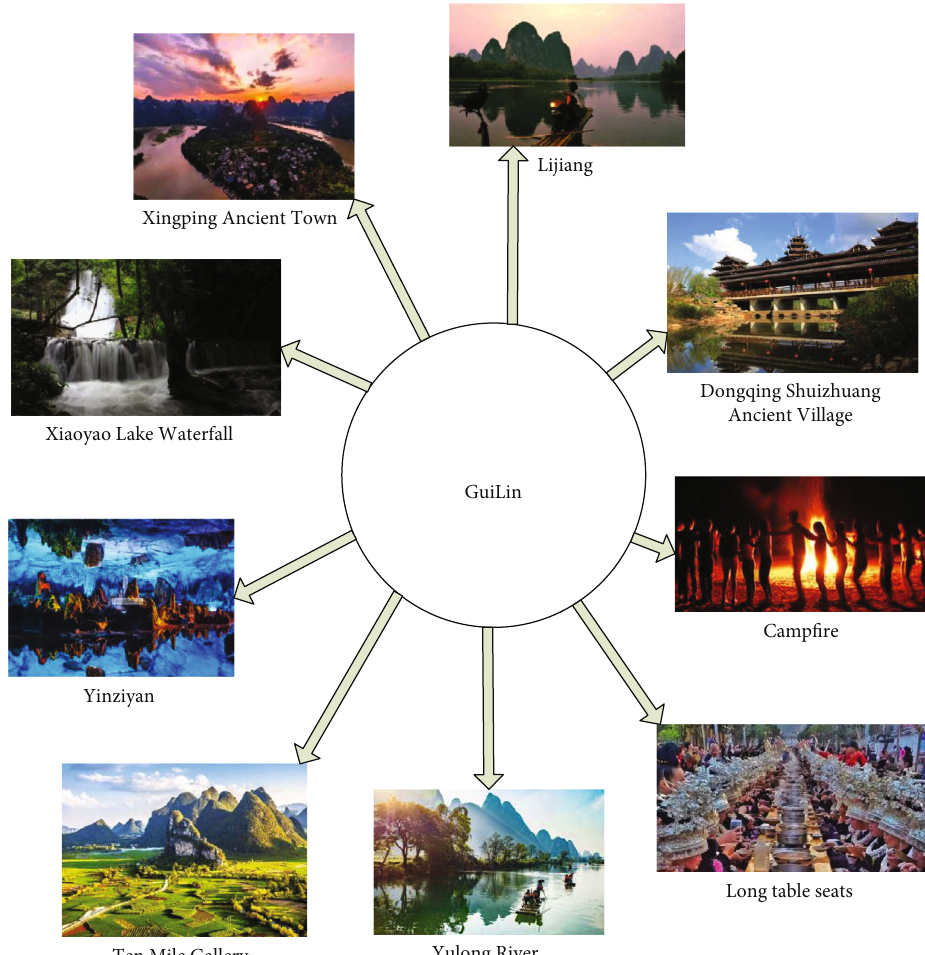
Figure 4: Famous scenic spots in Guilin,